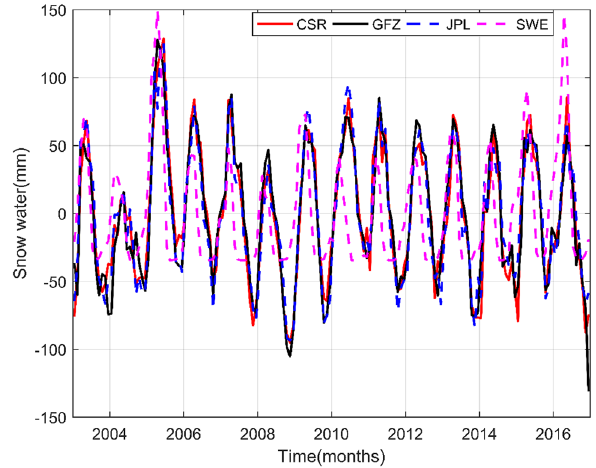
Fig. 7 Residual average monthly SM variation (mm) of GB from GLDAS-Noah model and residual average monthly TWS variation from GRACE (CSR, GFZ, JPL) signal